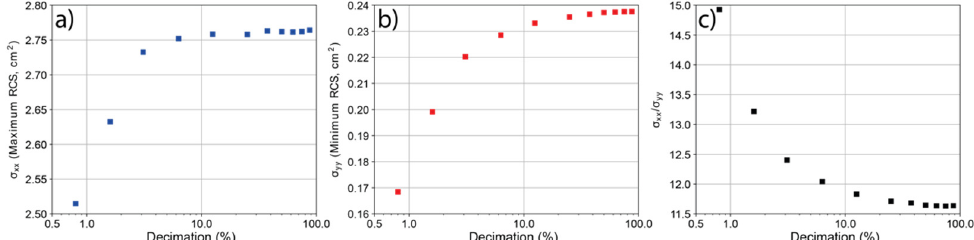
Figure 8. ( a ) Modelled maximum ( σ xx ) and ( b ) minimum ( σ yy ) RCS values, and ( c ) their ratio ( σ xx / σ yy ), for all decimations simulated in this study. These values are based on incident radiation of 9.4 GHz at a ventral incident angle and are from a simulation that excludes the impact of the wings, legs and antennae and assumes the specimens has a dielectric constant equal to that of MirkLBG (Table 1).